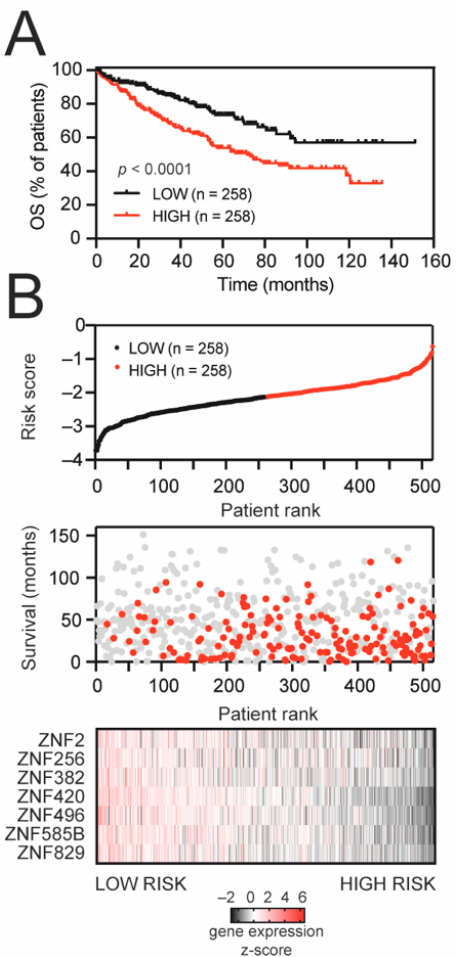
Figure 3. KRAB-ZNF-based gene signature for survival prediction in KIRC patients. ( A ) Kaplan– Meier survival curves for the entire TCGA KIRC set, stratified into high-risk and low-risk groups based on median value of developed risk score. Red and black denote high- and low-risk patients, respectively. ( B ) The signature-based risk score distribution (upper panel: red—high risk, black—low risk), patients’ survival status (middle panel: red—dead, grey—alive), and heatmap of seven KRAB-ZNF expression profiles (lower panel: black—downregulated, red—upregulated expression) in the entire KIRC set.